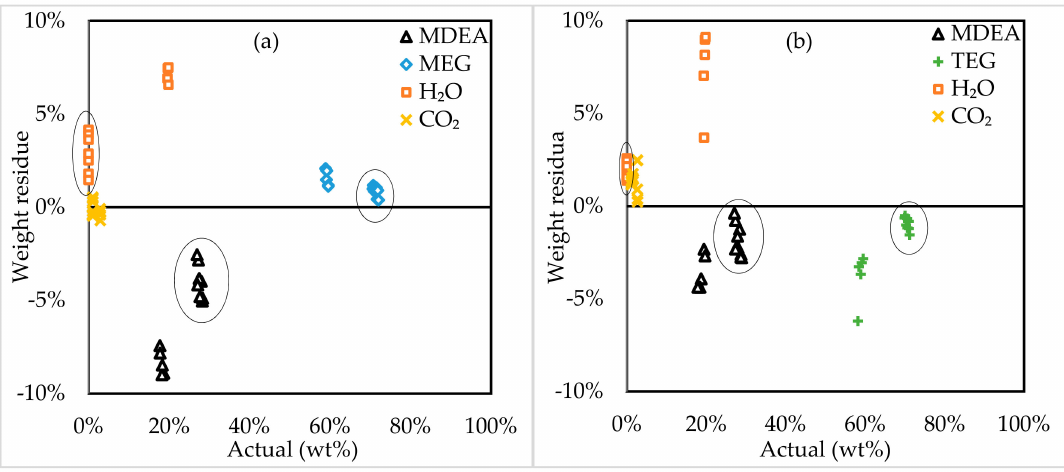
Figure 11. Actual vs. predicted values of experimental data; the MDEA-MEG-H 2 O-CO 2 system ( a ) and MDEA-TEG-H 2 O-CO 2 system ( b ).